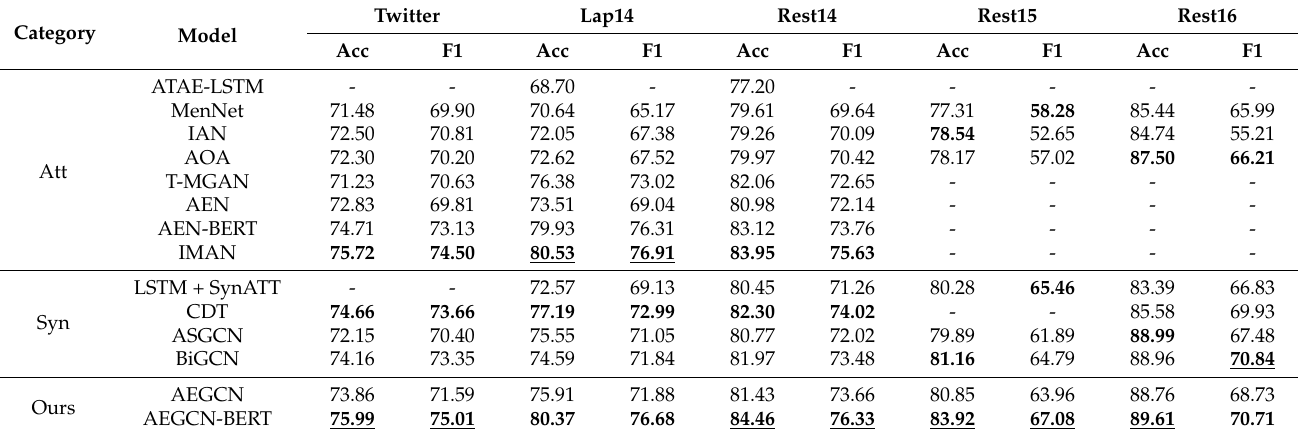
Table 2. Model comparison results of accuracy and macro-F1(%) on five datasets. The best results of different categories in each dataset are shown in bold. The best results in all models are bolded and underlined. “-” means not reported.